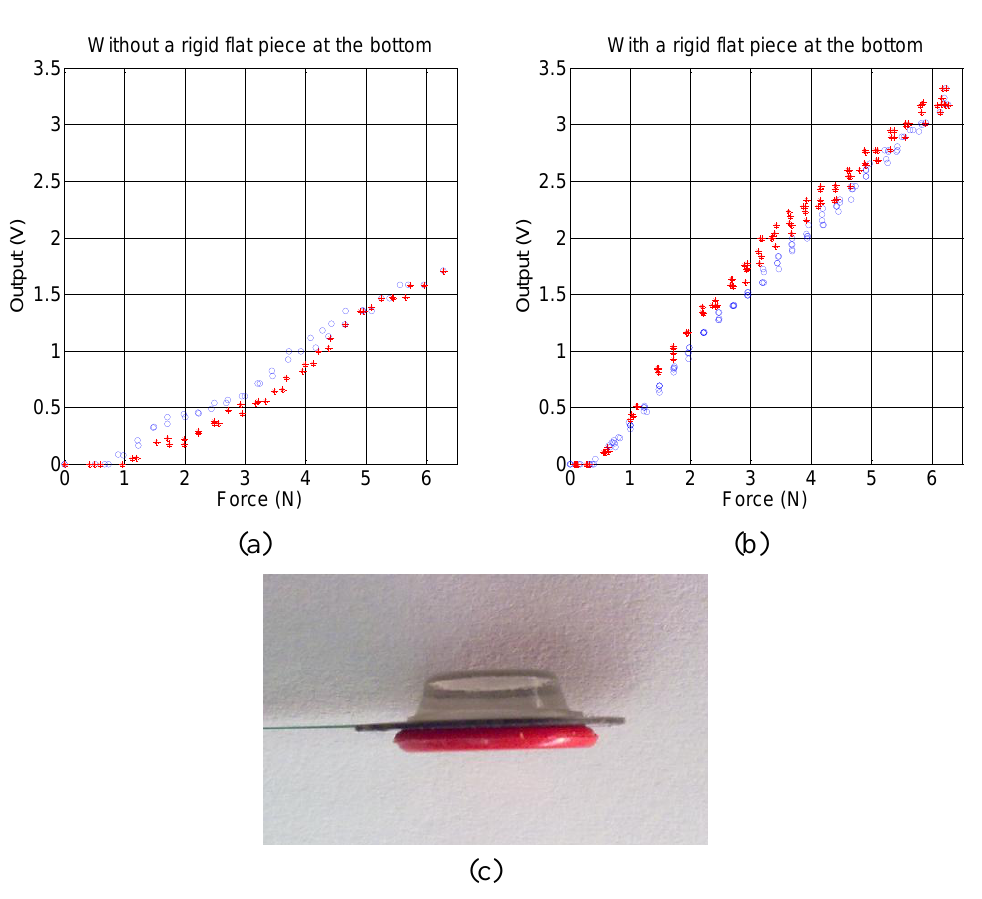
Figure 9. ( a ) Tactel output without and ( b ) with a rigid flat piece at the bottom. ( c ) Photograph of the modified